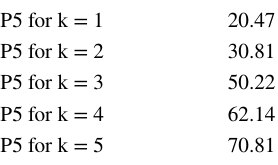
of ensemble of MDPs: MDP MDP Proj Gen + (considering last two